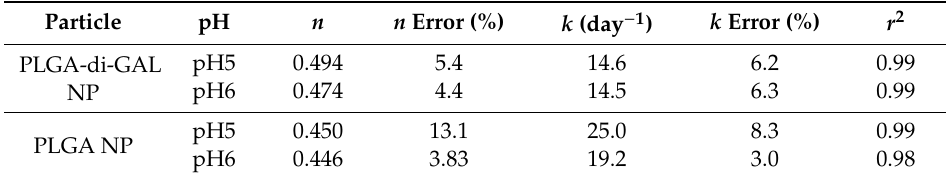
Table 3. Di ff usion exponent n and constant k, according to Equation (1), for DOX release from PLGA-di-GAL NP and PLGA NP at pH 5 and